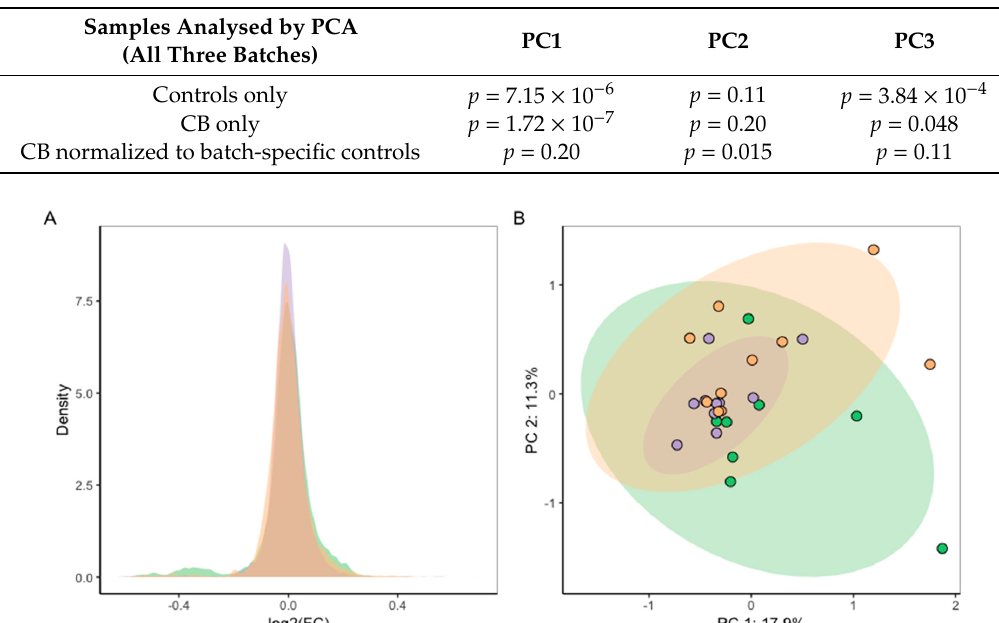
Table 1. ANOVA results comparing PC scores of control samples only, CB samples only, and CB samples normalised to the batch-specific controls, in each case over the three independent biological batches.